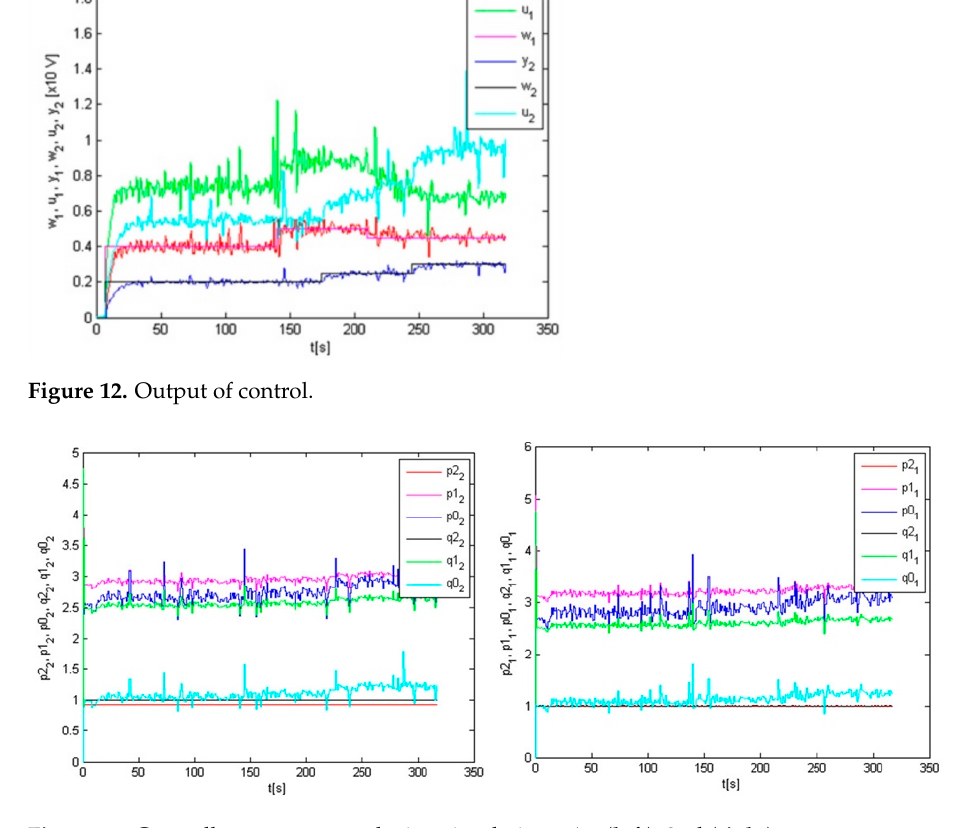
Figure 13. Controllers parameters during simulation—1st ( left ), 2nd ( right ).